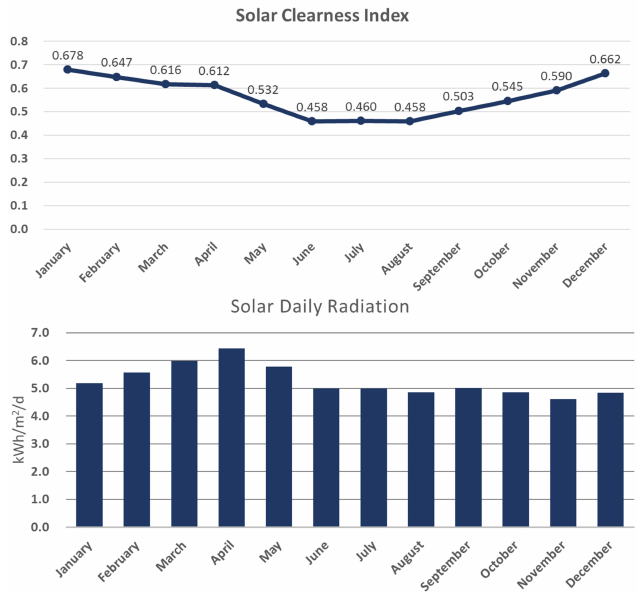
Figure 4. Solar resource information of Chiang Mai University (created by the